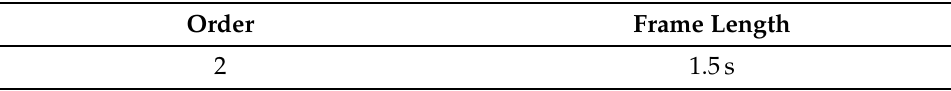
Table A3. Parameters for Savitzky Golay pre-processing filter.